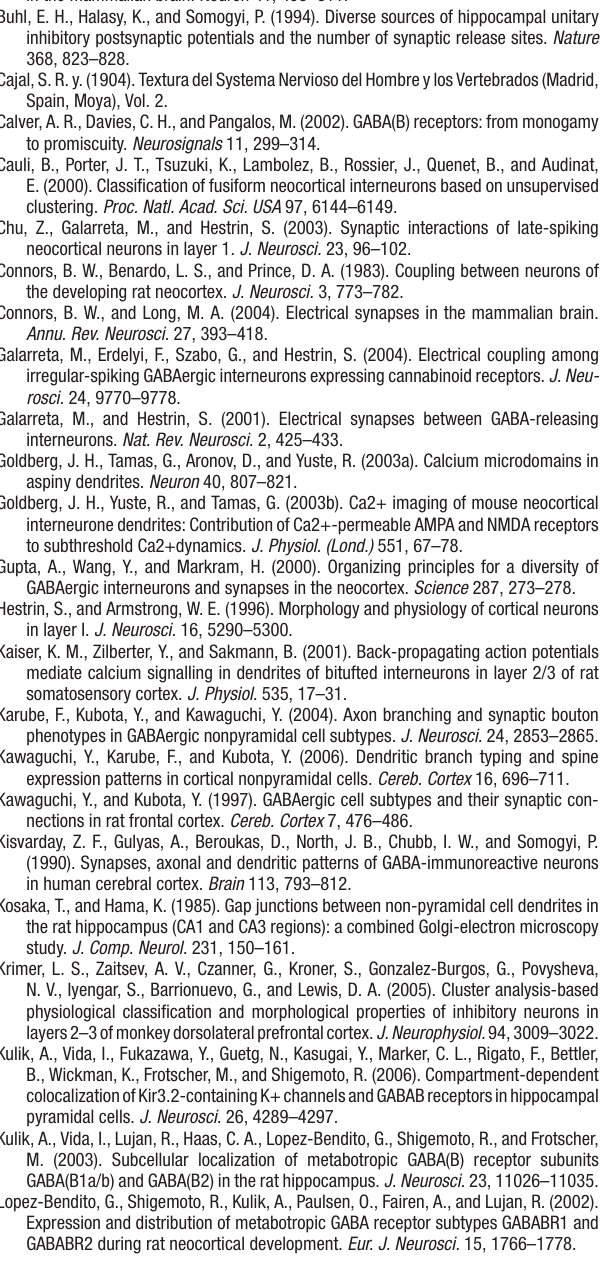
recording unitary IPSPs elicited by neurogliaform cells allowed the iden- tification of GABAB receptors expressed by fast spiking basket cells, it appears that the actual ratio of GABAA and GABAB receptor involvement in the output of neurogliaform cells could be connection specific and primarily determined by the postsynaptic cell